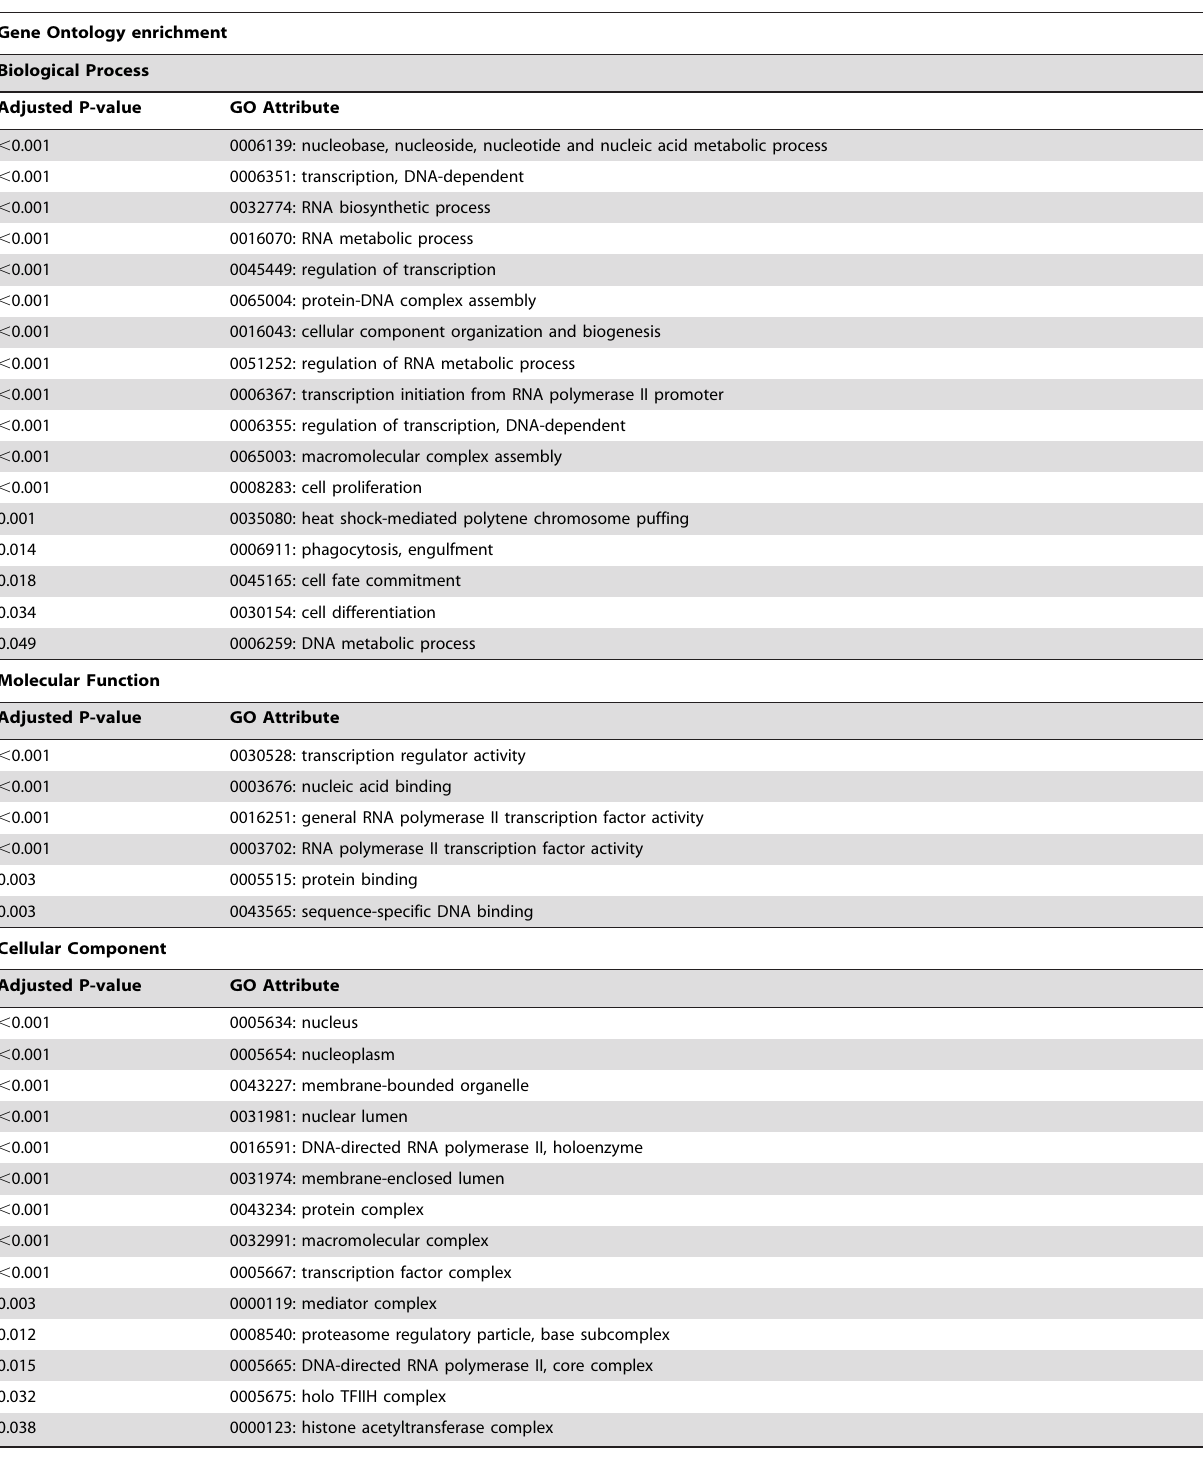
Table 2. Categories of Gene Ontology enrichment within the validated MMS survival